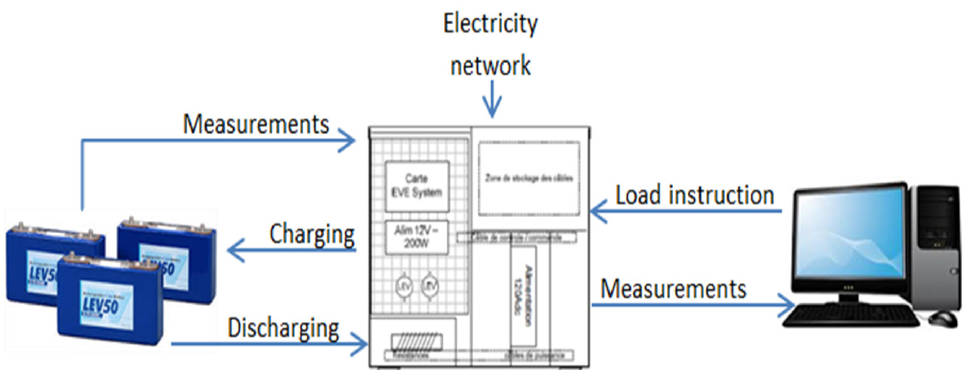
Figure 3. Experimental setup.